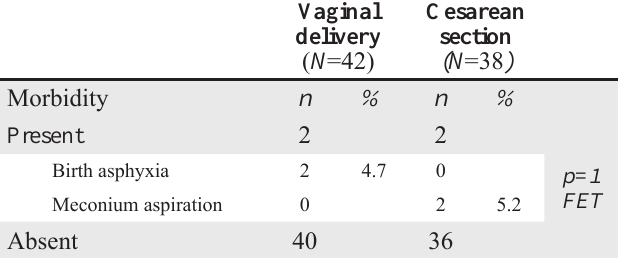
Table 2 : Perinatal morbidity by mode of delivery